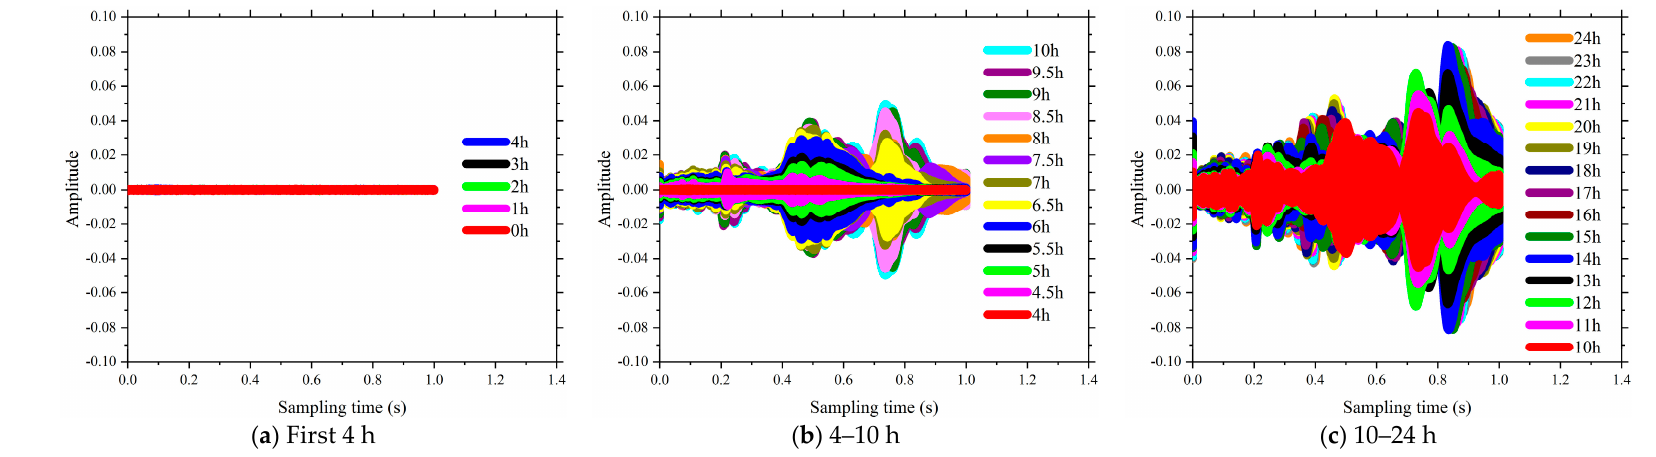
Figure 13. Influence of volume of fly ash on the signal amplitude at hydration monitoring (FA-0%).